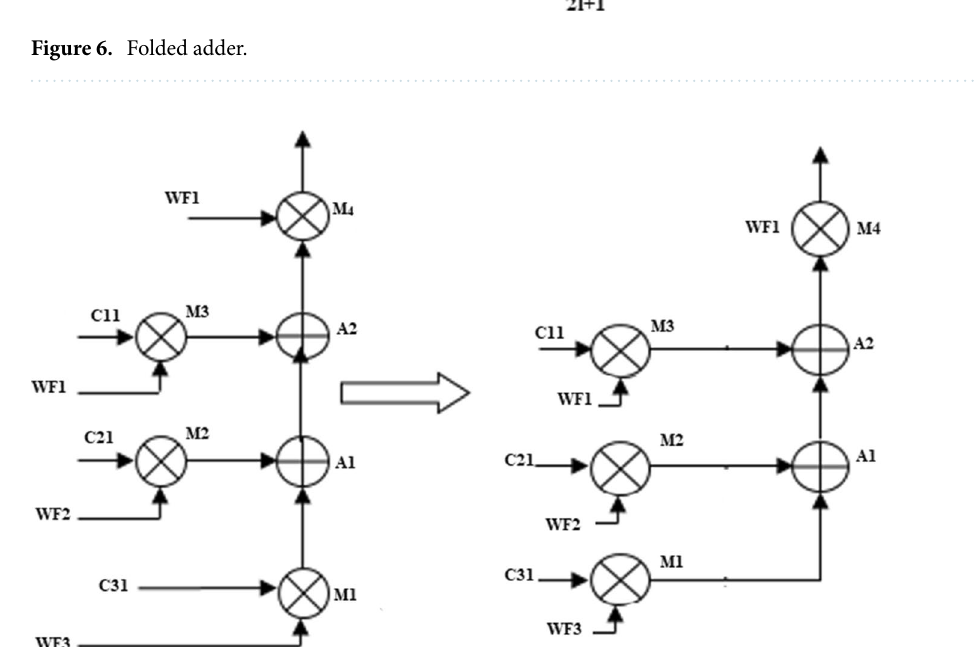
Figure 7. Block1 of